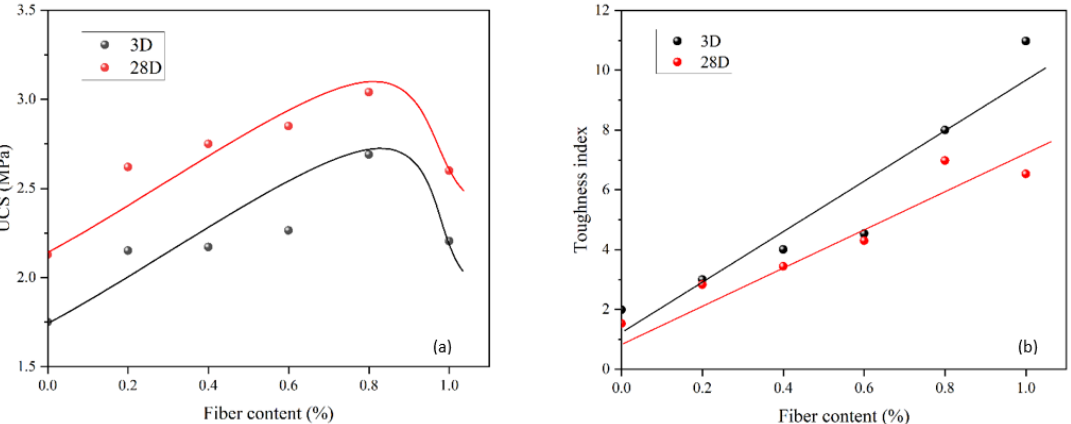
Figure 10. UCS for different fiber contents ( a ) and toughness indices for different fiber contents ( b ) at rubber content of 60% and 9 mm in fiber length.